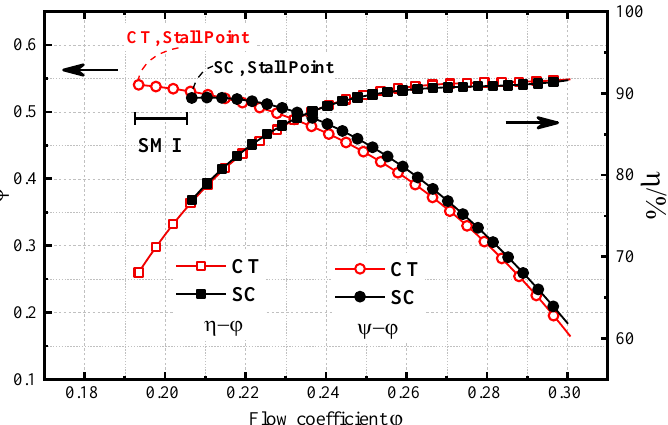
Figure 4. Compressor performance characteristics: pressure rise characteristic ( left ); efficiency characteristic ( right ).